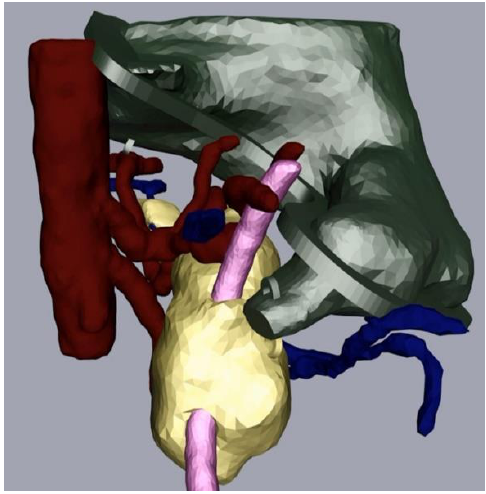
Figure 4. Pancreas (yellow), arteries (red) veins (blue), stomach with flange and hooks (green) and splint (pink) after processing.